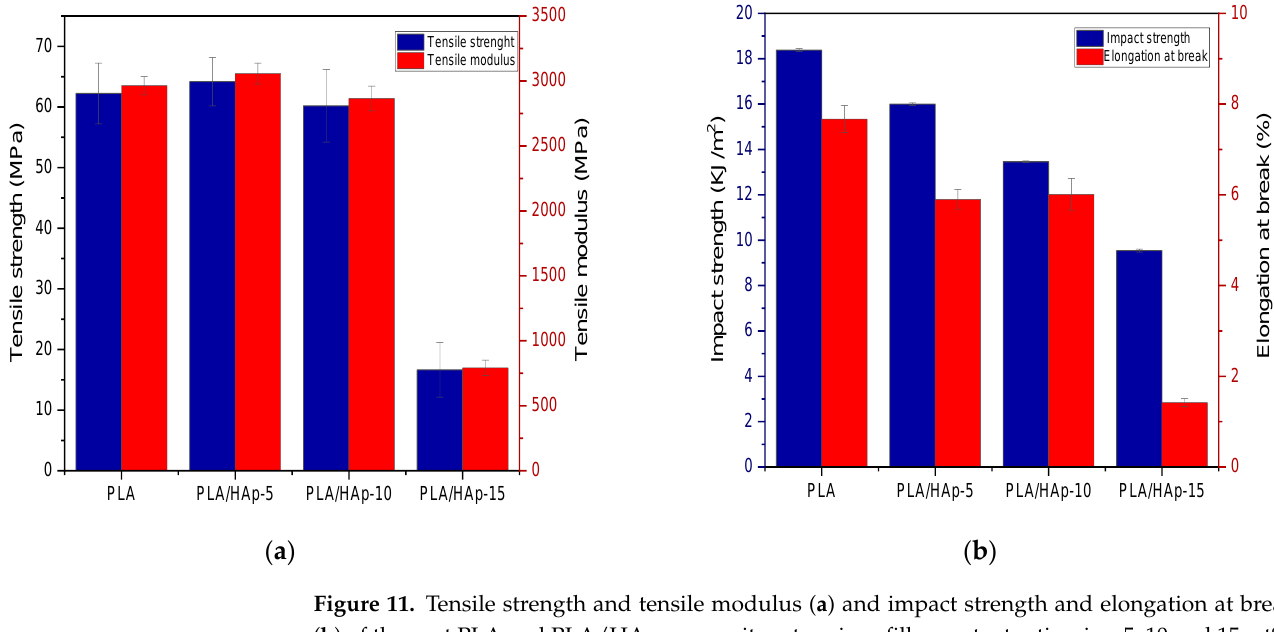
Figure 11. Tensile strength and tensile modulus ( a ) and impact strength and elongation at break ( b ) of the neat PLA and PLA/HAp composites at various filler content ratios, i.e., 5, 10 and 15 wt%.